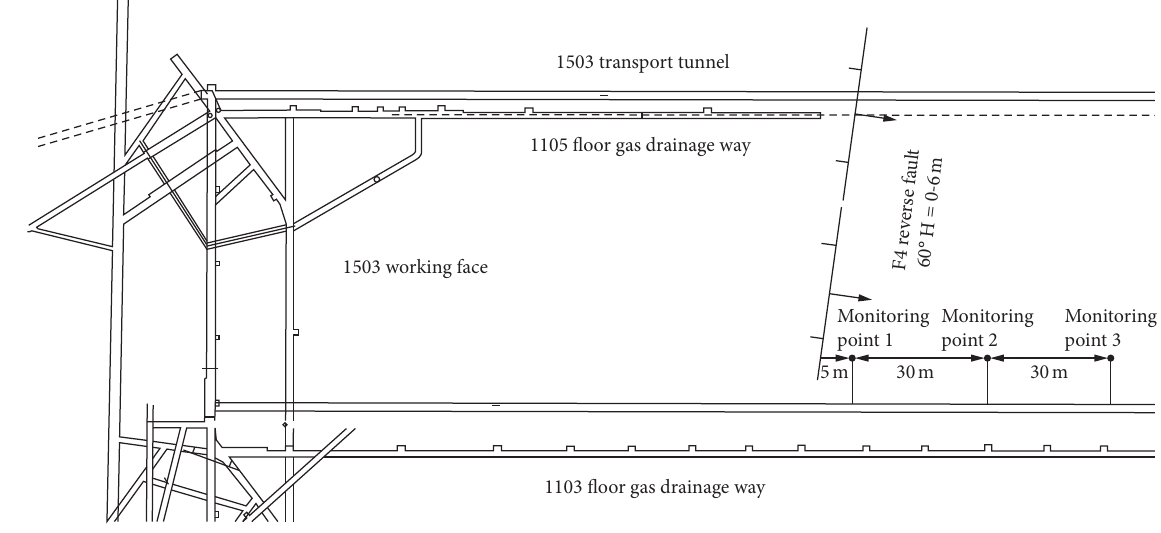
Figure 2: Map of 1503 working